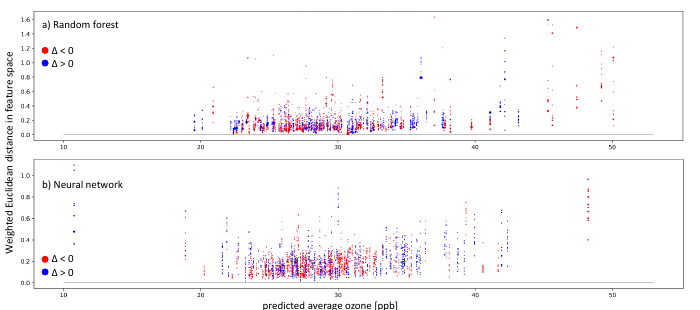
Figure 9. Plots showing inaccurate predictions (absolute values of ∆ > 5 ppb) on the test set by the random forest ( a ) and neural network ( b ). The weighted Euclidean distance in the respective feature space is on the y-axis. On the x-axis, the predicted average ozone is shown. The colors indicate the residual: red points mean negative residuals and model overestimation, while blue points show positive residuals and model underestimation. The size of the single dots points to the distance between the test sample and the training sample in the representation space. A larger dot means that the test sample and respective training sample lead to similar activation patterns in the